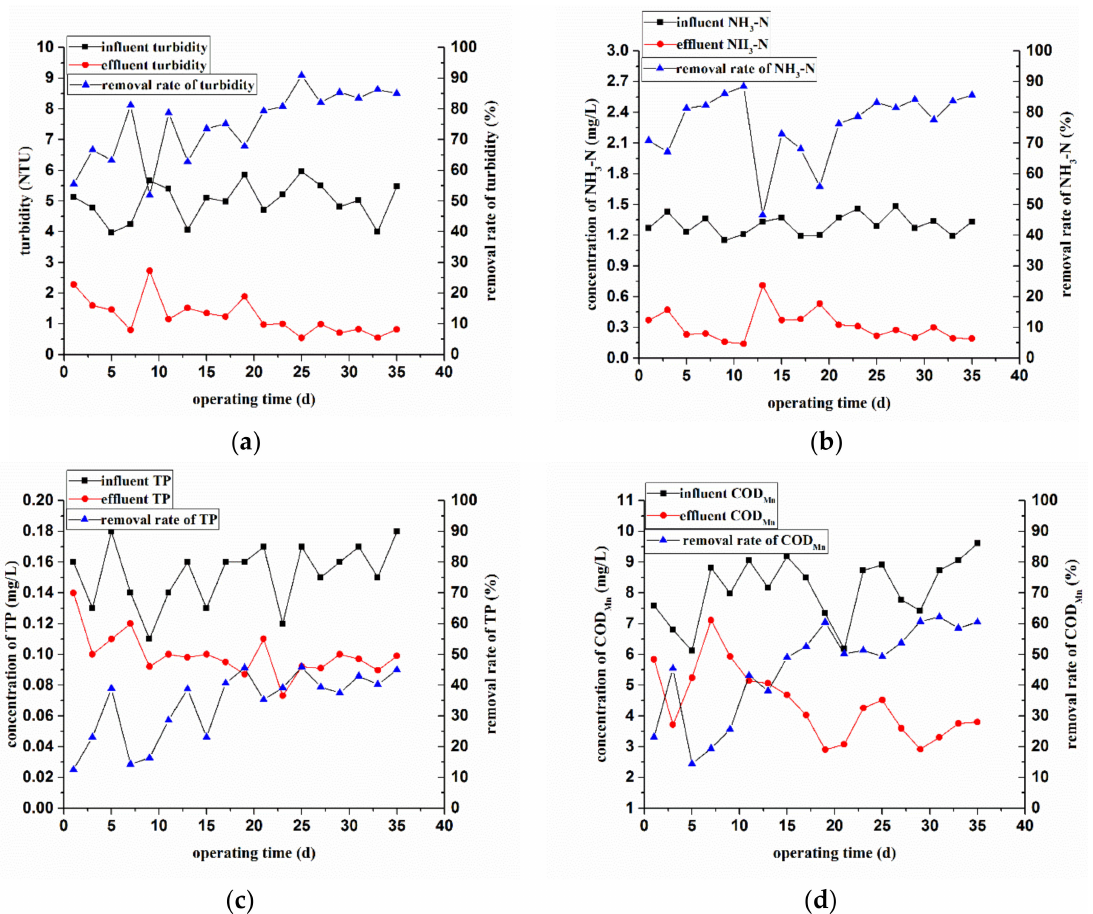
Figure 2. Removal efficiency of various pollutants in biological slow filtration system (( a ) turbidity, ( b ) NH 3 -N, ( c ) TP, ( d ) COD Mn